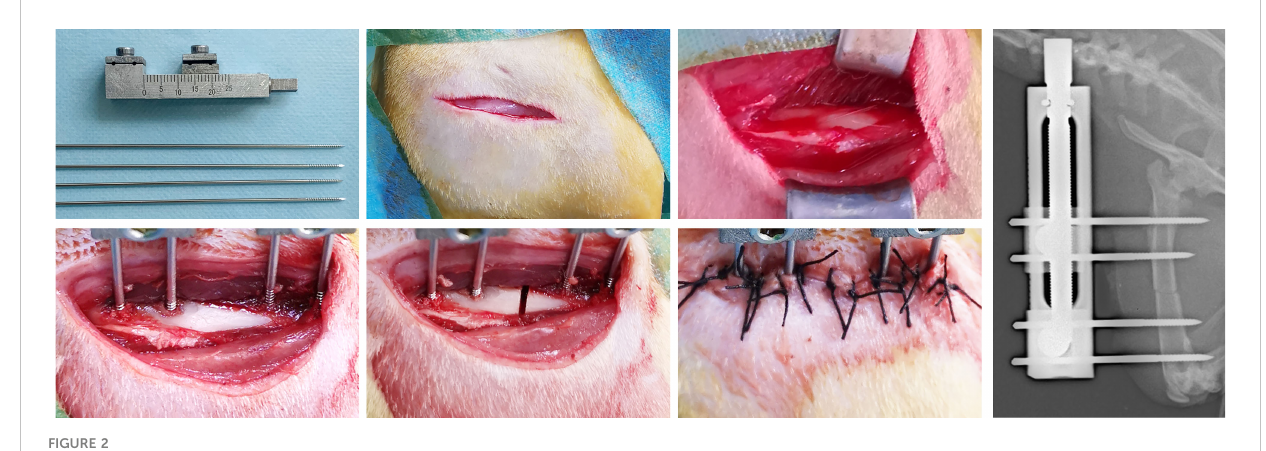
FIGURE 2 The surgical procedures for the rat right femur model of